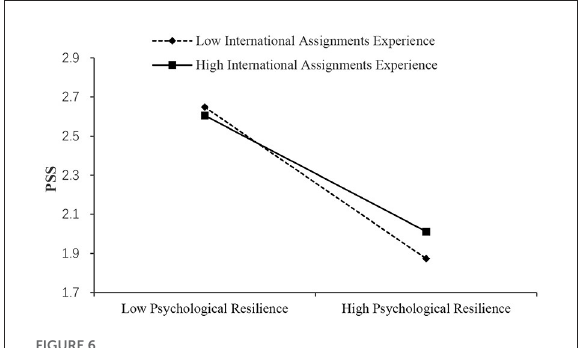
FIGURE6 Simple slopes of international assignments experience moderate the effect of psychological resilience on